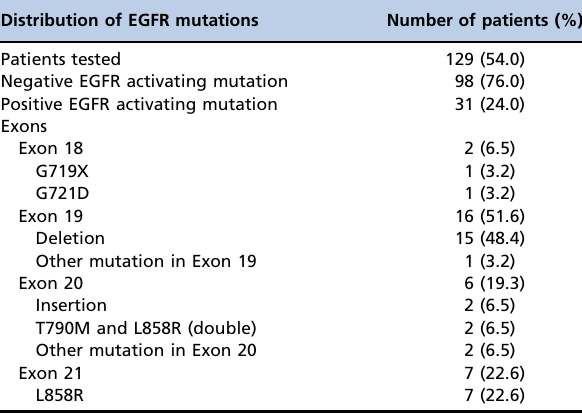
Table 2 - Distribution of EGFR mutation types among adenocarcinoma stage IV